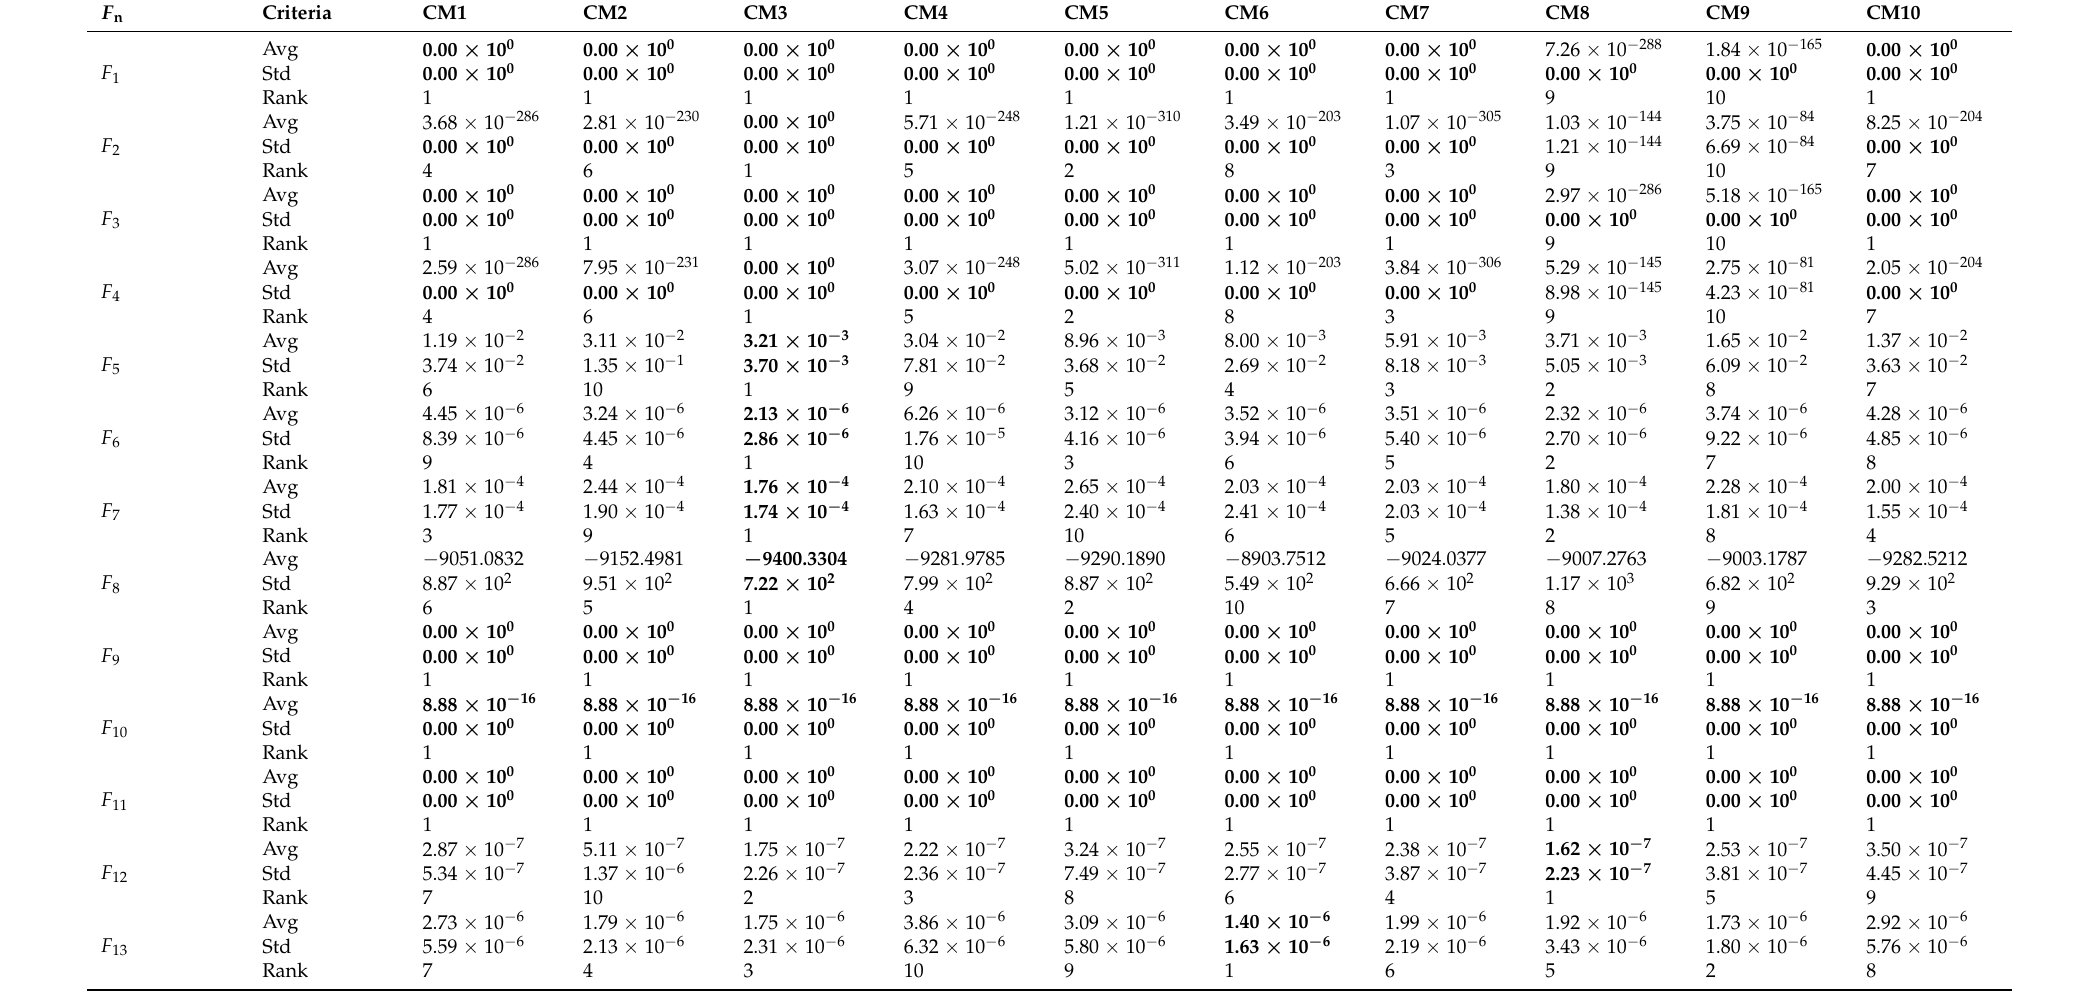
Table 5. Comparison results of different chaotic maps on 23 benchmark